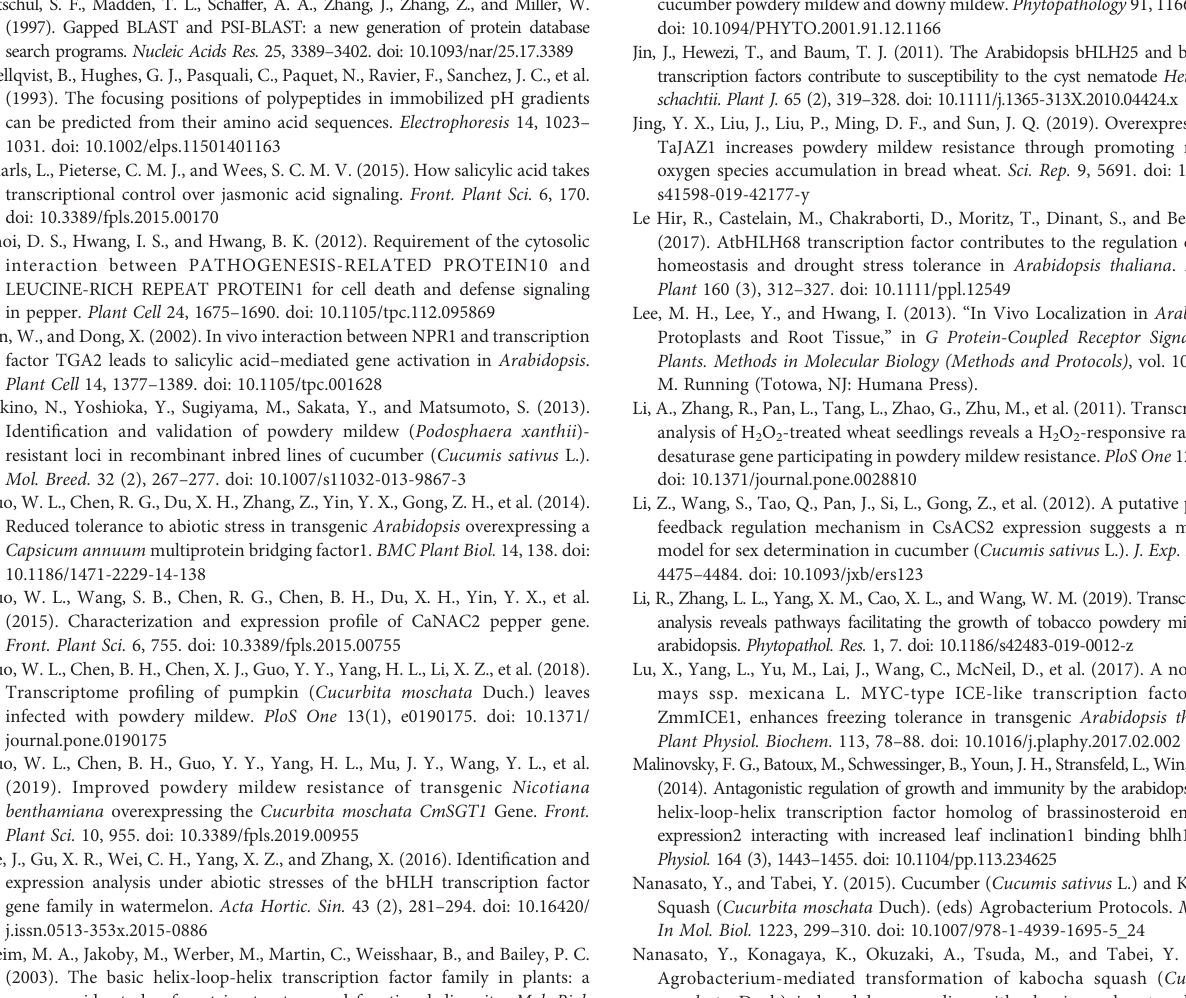
FIGURE S1 | A Neighbor-joining phylogenetic tree of CmbHLH87 and bHLH proteins from different plant species. The CmbHLH87 protein is marked with arrow. The bHLH subgroup names are shown to the right of square. FIGURE S2 | Amino acid sequences alignment of pumpkin CmbHLH87 with others. The conserved domains (bHLH) are shown by thin underlines. The genes included are bHLH87-like ( C. moschata cv. ‘ Rifu ’ , XP_022953326.1), bHLH87-like ( C. pepo , XP_023547764.1), bHLH87-like ( C. maxima, XP_022992322.1),